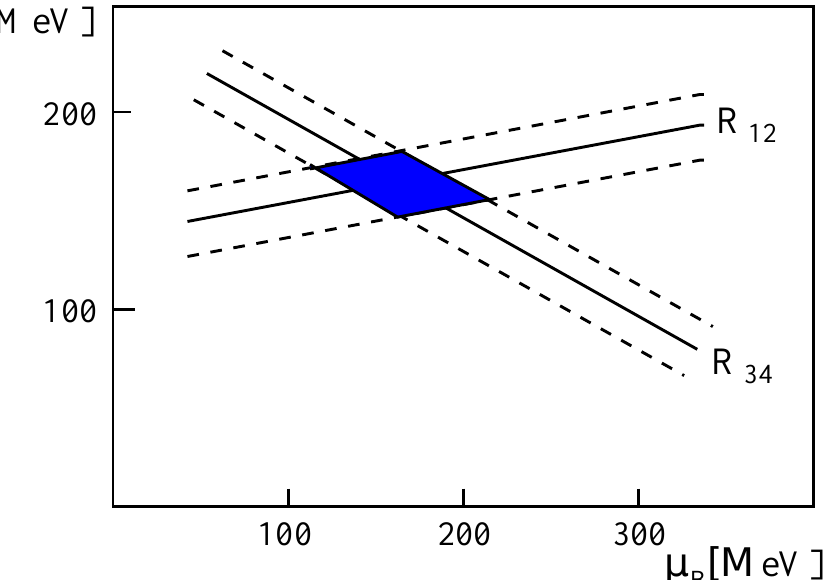
Figure 1. Thermal parameter values (shaded area) in the T – µ B plane obtained from two different Figure 1: Thermal parameter values (shaded area) obtained from two different abundance abundance ratios, R 12 and R 34 ; the error bands correspond to the measurement errors of the ratios. See text for ratios R and R ; the error bands correspond to the measurement errors of the ratios. 12 34